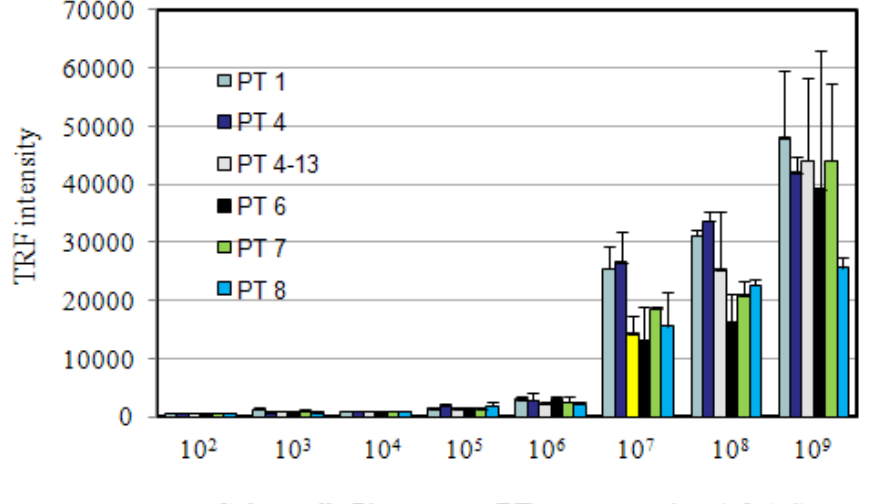
Figure 3. Sensitivity of immunomagnetic bead time-resolved immunofluorescence (IMB- TRF) for detection of Salmonella Enteritidis phage types